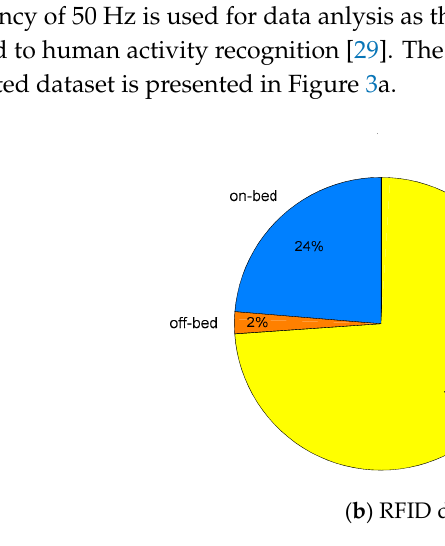
Figure 3. Proportion of data samples in each dataset.